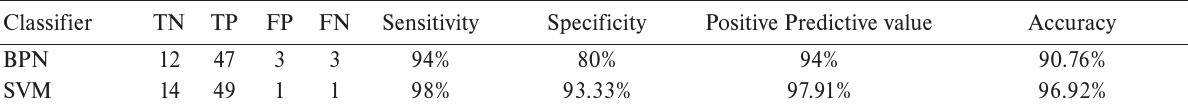
Table 5. Analysis of classification results (Combined features).